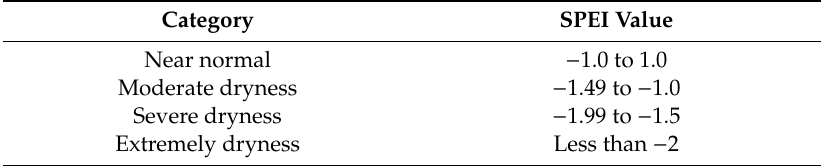
Table 1. Categorization of drought severity by the Standardized Precipitation Evapotranspiration Index